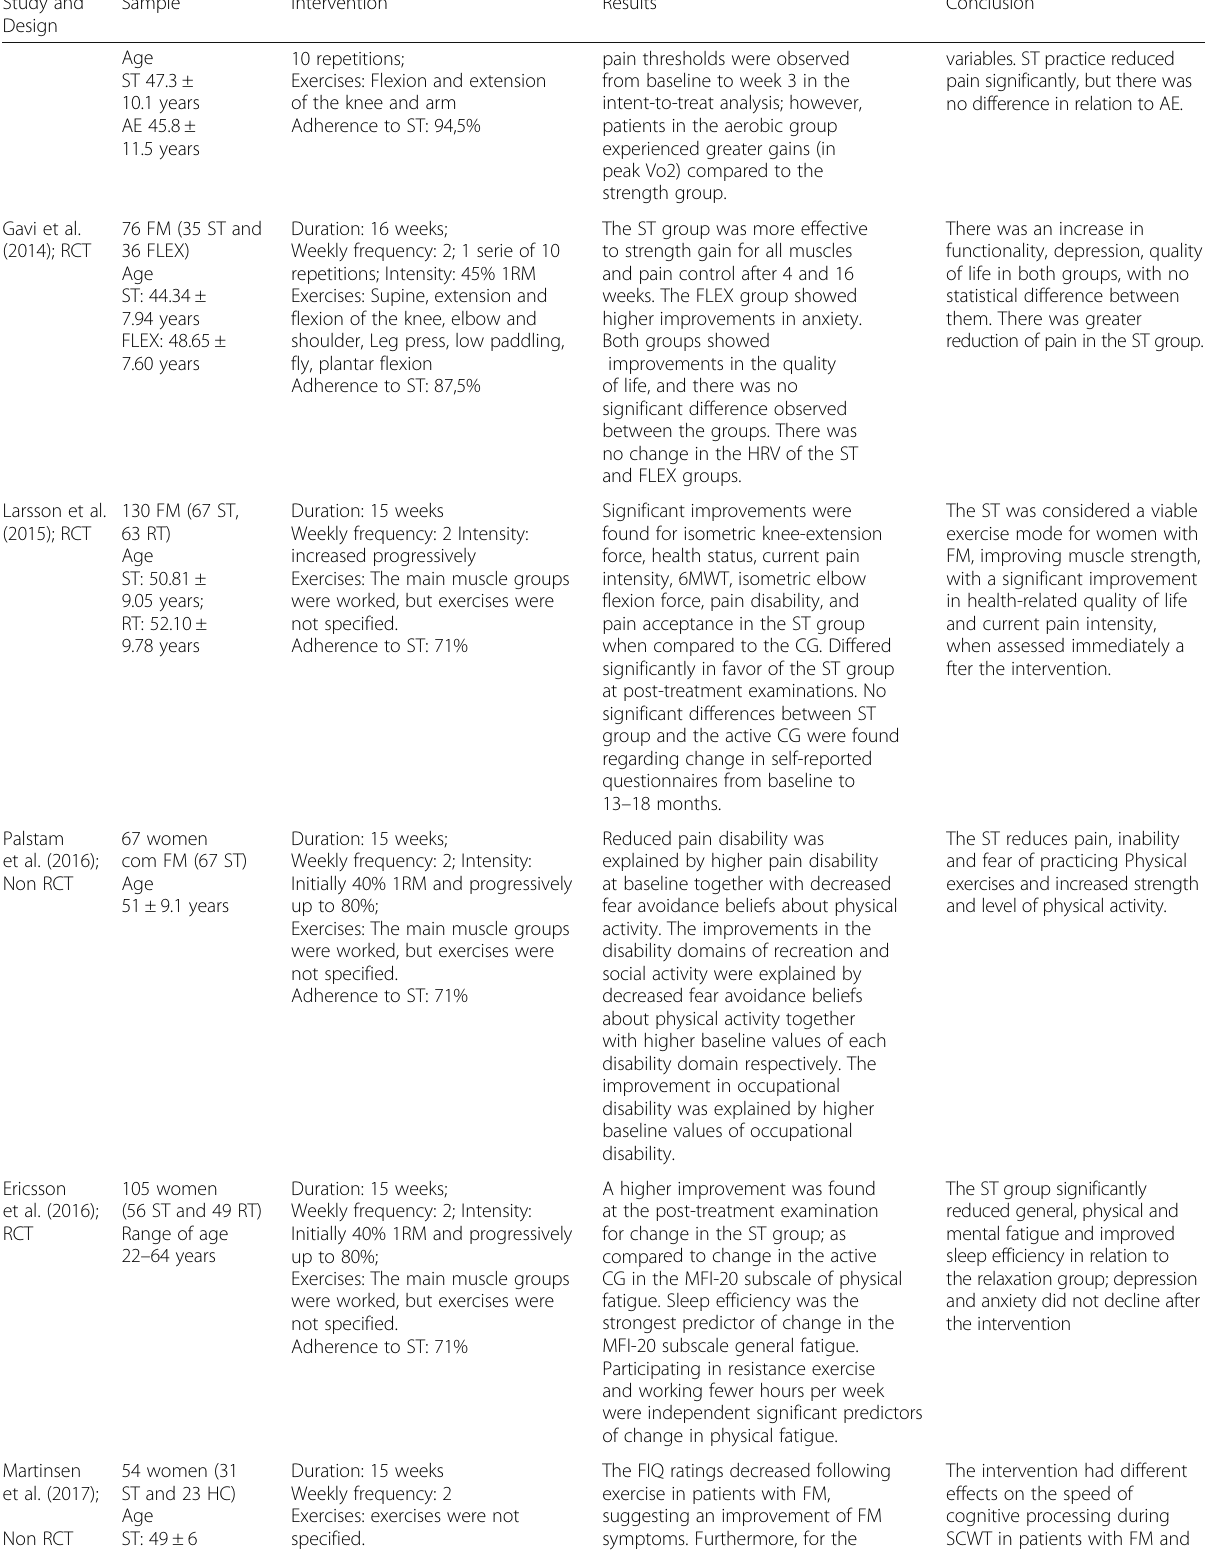
Table 2 Characteristics and results of experimental studies with strength training for patients with fibromyalgia syndrome (Continued) Study and